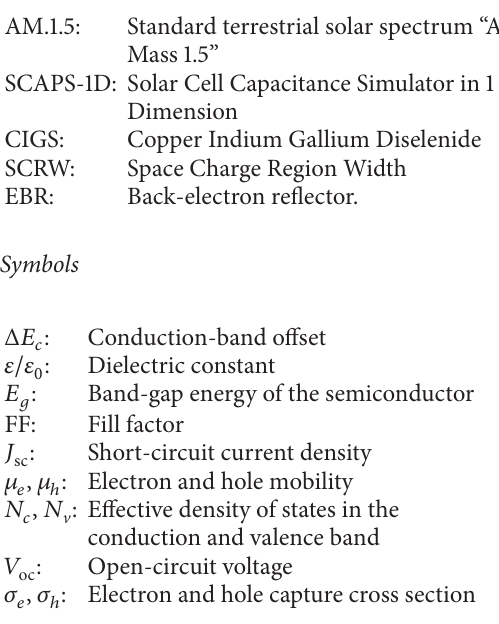
, FF, and efficiency) as a function of the CIGS absorber sc